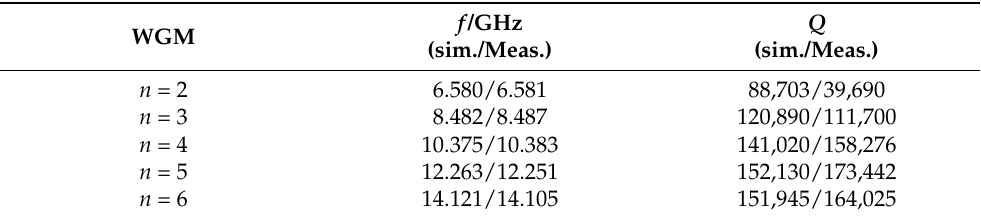
Table 1. Whispering gallery modes with n = 2 to n = 6 ( l = 1, m = n ). Simulated (sim.) versus measured (meas.) resonant frequency ( f ) and Q factor.